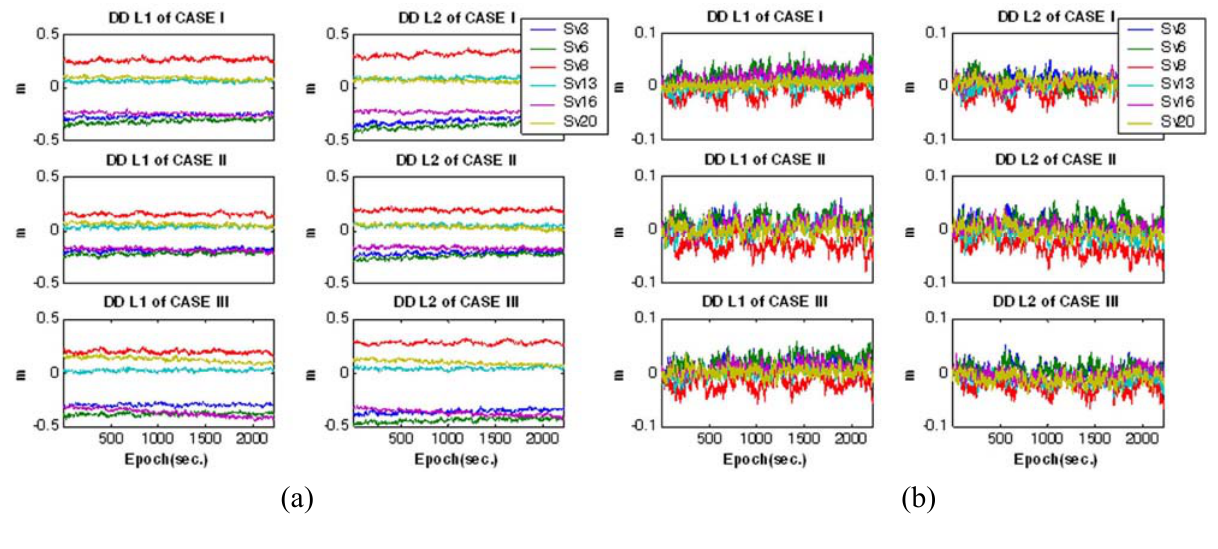
Figure 8. DD residuals of mobile receivers. (a) Single-reference station mode. (b) Multiple-reference stations